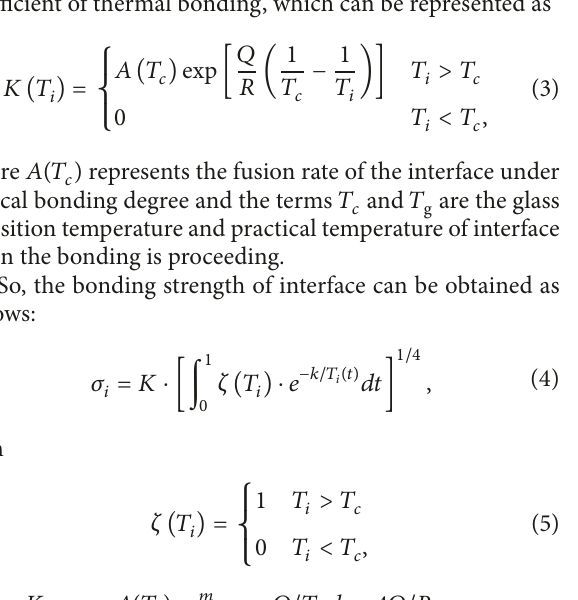
The terms 𝜎 𝑖 and 𝜎 𝑓 represent the interface bonding strength and tensile strength of the material, respectively. 𝐾(𝑇 𝑖 ) is coefficient of thermal bonding, which can be represented